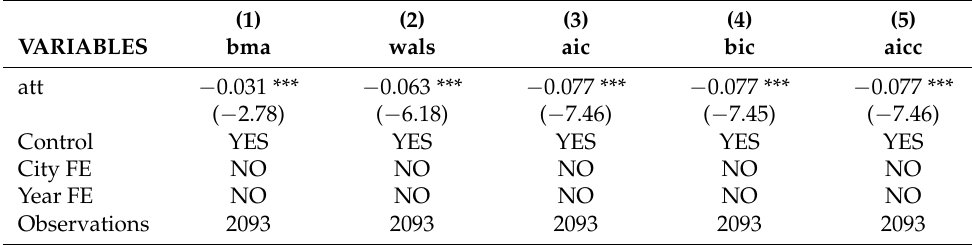
Table 7. Model averaging for CE.